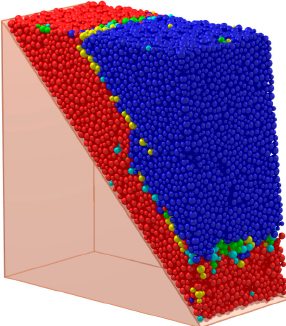
Figure 17. The clusters of the slope in state 2.